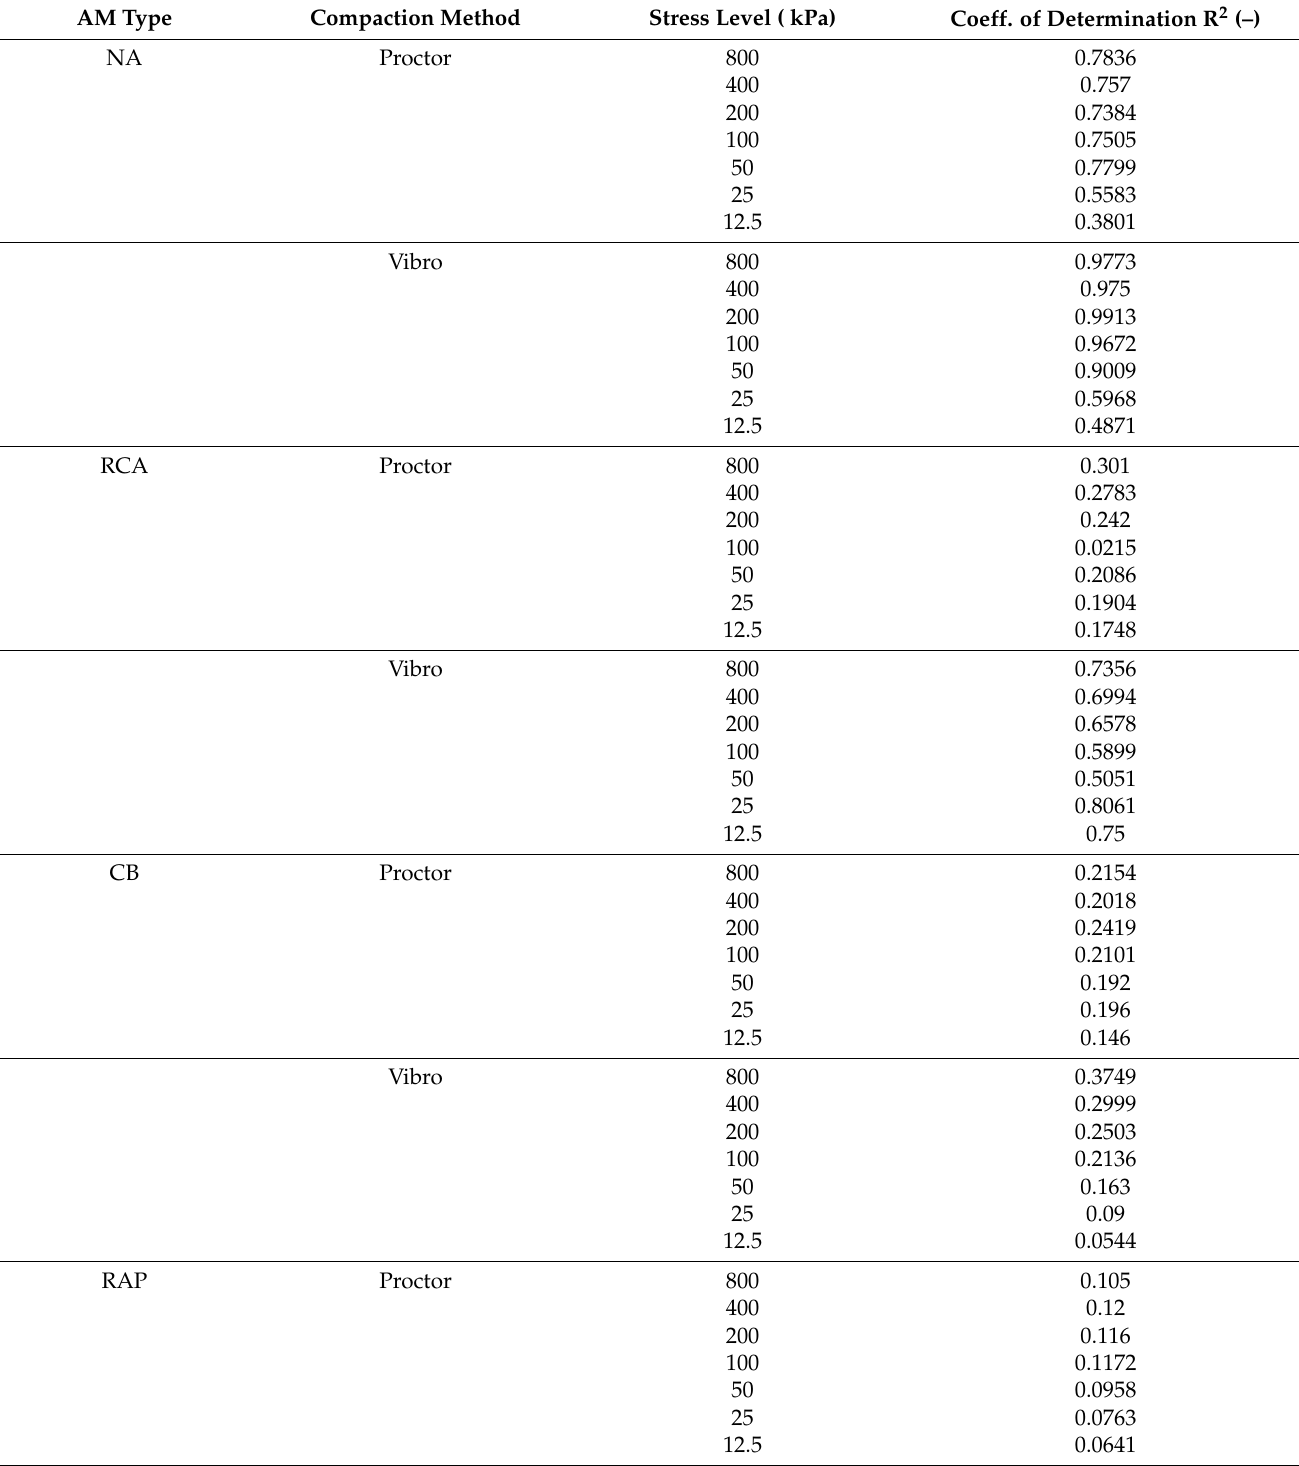
Table A6. Coefficient of determination values for stress levels in Figures